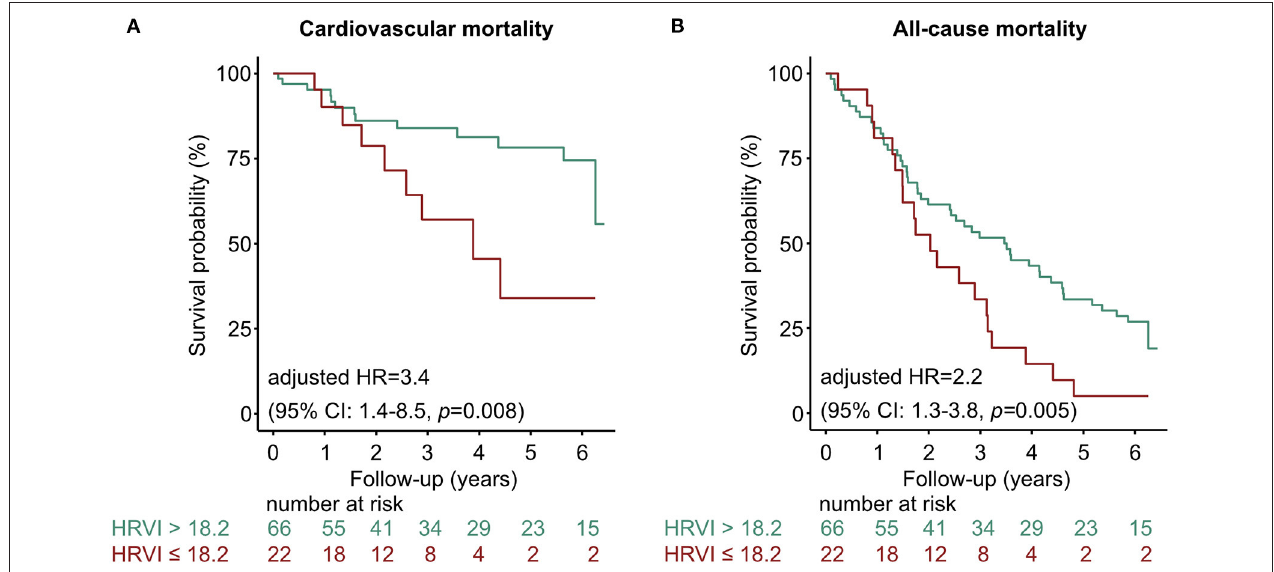
FIGURE 4 | Kaplan-Meier curves stratified at the border of the first HRVI quartile for (A) cardiovascular and (B) all-cause mortality. The 3-year cardiovascular mortality rate was 31.8 and 13.6% if HRVI was ≤ 18.246 and > 18.246, respectively. The 6-year cardiovascular mortality rate was 40.9 and 18.2% if HRVI was ≤ 18.246 and > 18.246, respectively. For all-cause mortality the 3-year mortality rate was 63.4 and 45.5%, and the 6-year mortality rate was 90.9 and 68.2% if HRVI was ≤ 18.246 and > 18.246, respectively. Hazard ratios are adjusted for the Charlson Comorbidity Index and the Cardiovascular Mortality Risk Score and show a 3.4- and 2.2-times increased risk of cardiovascular and all-cause mortality if HRVI was ≤ 18.246, respectively. CI, confidence interval; HR, hazard ratio; HRVI, heart rate variability triangular